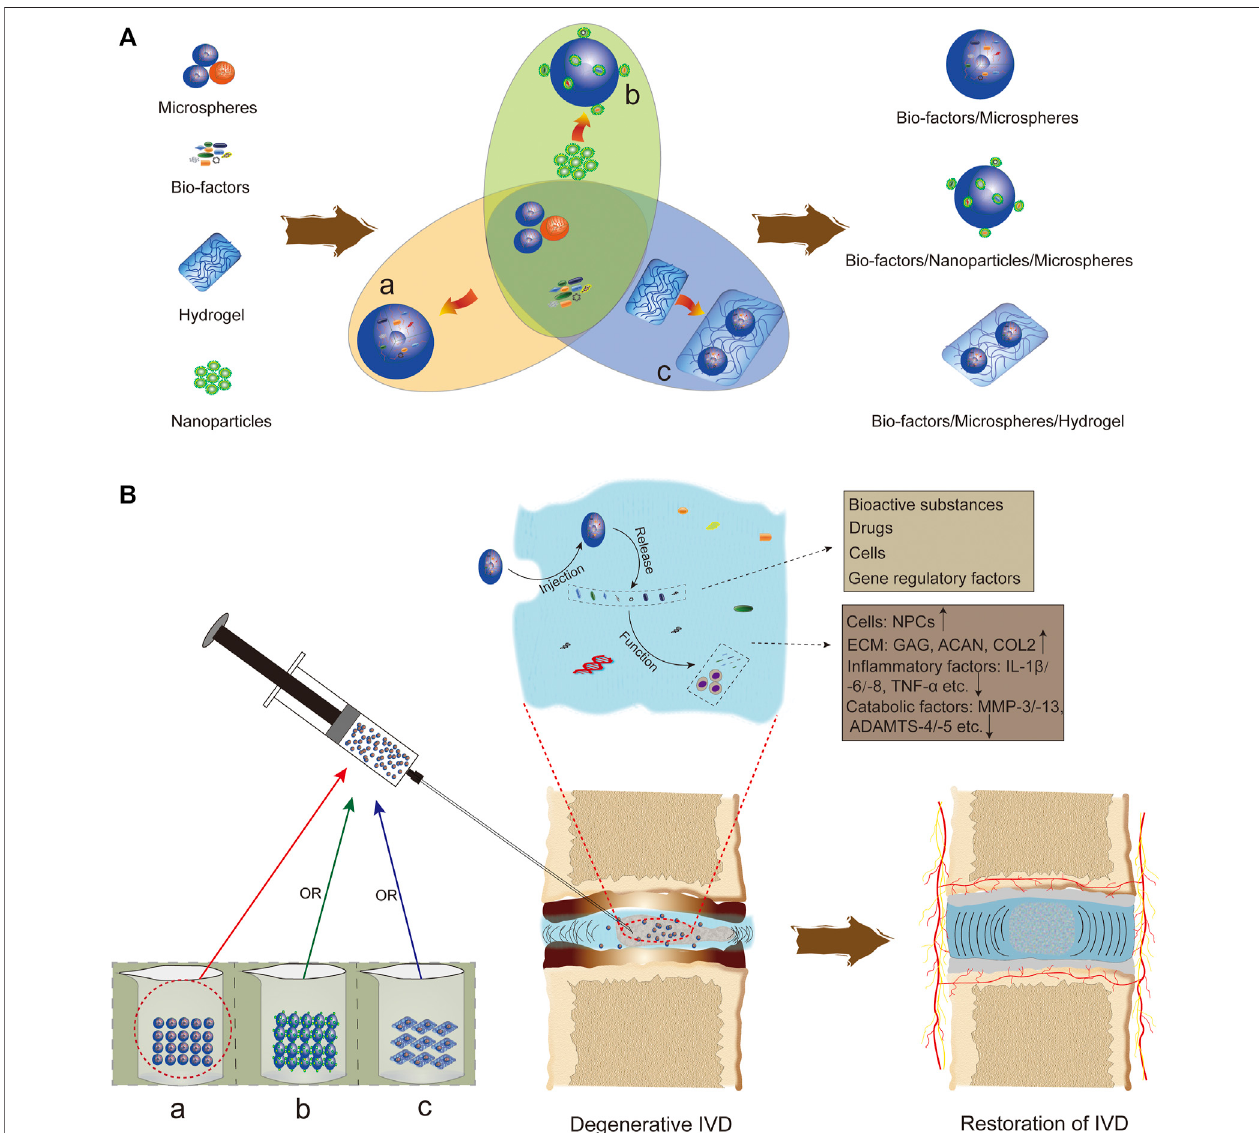
FIGURE5| Application ofmicrospheresinIVDD. (A) Currently,there arethree formsofmicrosphere-based delivery systemsforIVDD: (a) biofactors areloaded on microspheresbymicroencapsulation; (b) somebiofactorsareadheredtomicrosphereswiththehelpofnanoparticles;and (c) microspheresareembeddedinhydrogels after loading biofactors. (B) The microsphere delivery system plays a role through in situ injection into IVD tissue, including increasing IVD cells, promoting IVD matrix formation, and inhibiting the expression of in fl ammatory factors and catabolic mediators.